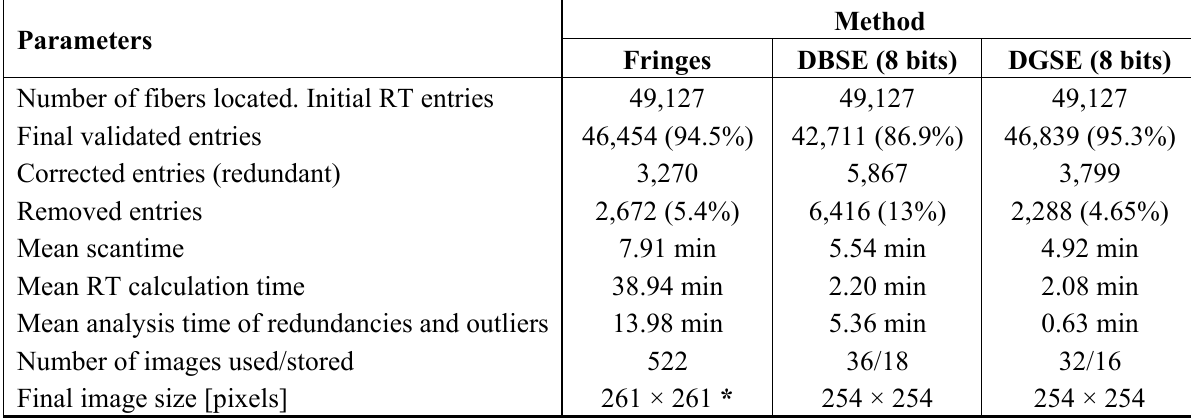
Table 2. Comparison between different calibration techniques